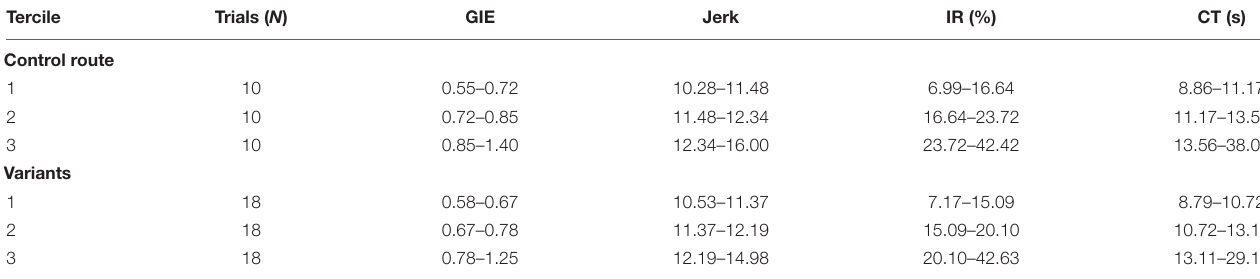
TABLE 2 | The interval values identifying the terciles for the geometric index of entropy (GIE), jerk, immobility ratio (IR, in percentage), and climbing time (CT, in seconds). Tercile Trials ( N ) GIE Jerk IR (%) CT